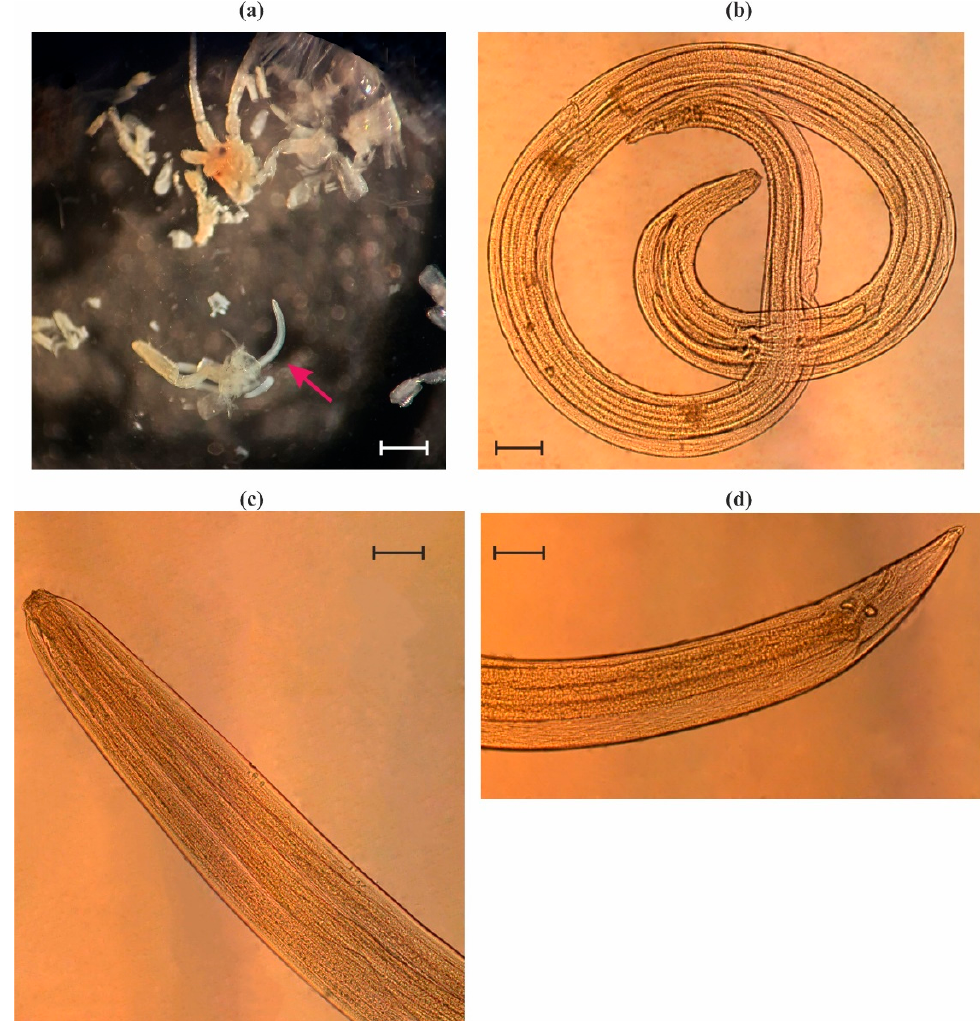
Figure 2. Nematode larva in Ischyrocerus commensalis . ( a )—dissected amphipod with nematode larva (arrow), scale bar 1 mm; ( b )—light microphotograph of nematode larva, overall view, scale bar 0.1 mm; ( c )—anterior end, scale bar 0.1 mm; ( d )—posterior end, scale bar 0.1 mm.